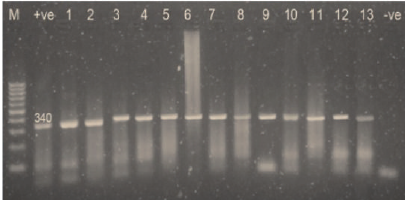
Figure 2: Analysis of seminested PCR products (outer primer pair only) by 1.5% agarose gel electrophoresis and ethidium bromide staining showing the positive samples after the primary amplifica- tion